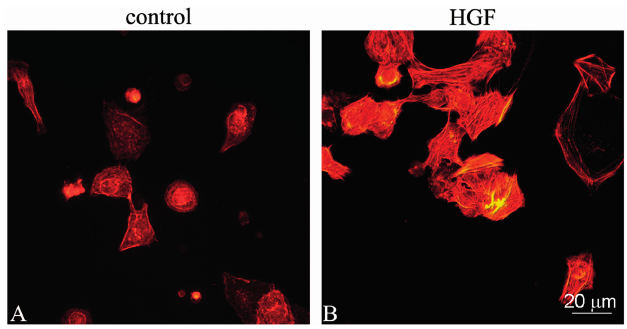
Figure 1. F-actin distribution pattern in cultured myoid cells purified from prepubertal